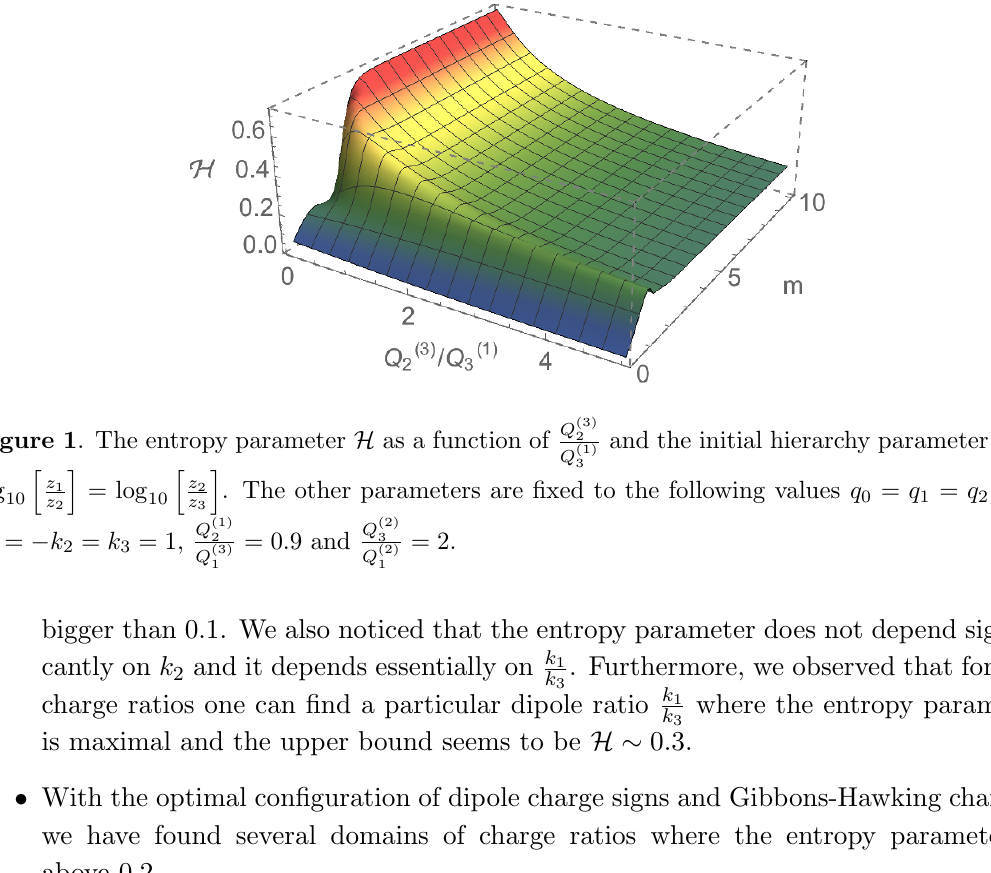
Figure 1 . The entropy parameter H as a function of Q